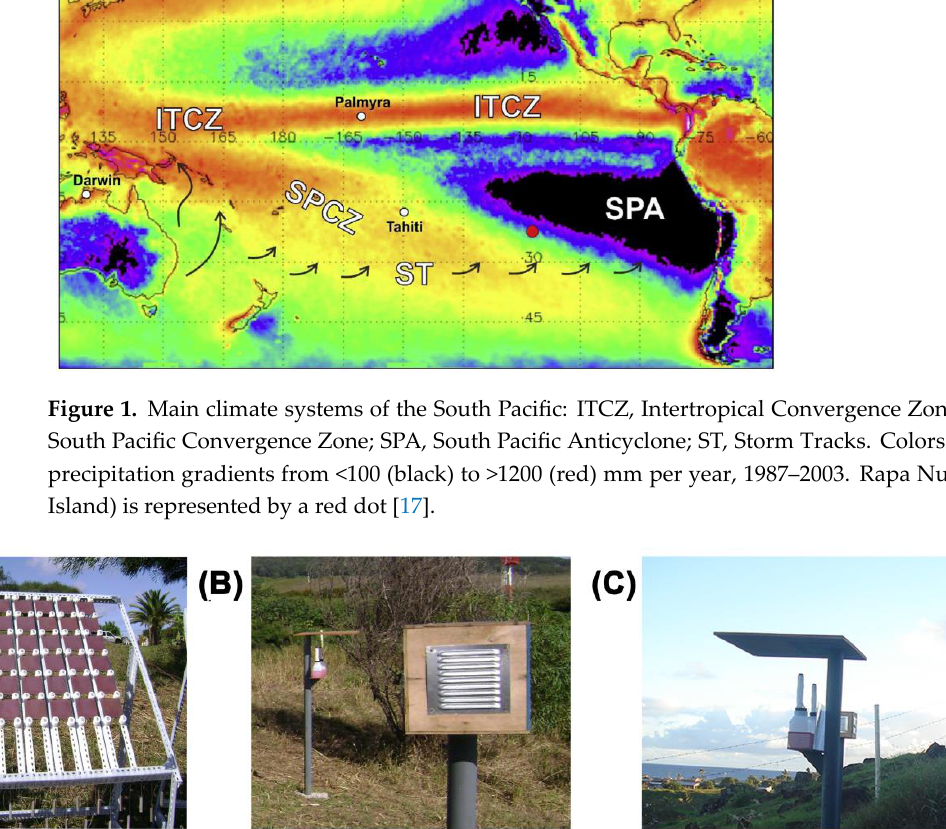
Figure 1. Main climate systems of the South Pacific: ITCZ, Intertropical Convergence Zone; SPCZ, South Pacific Convergence Zone; SPA, South Pacific Anticyclone; ST, Storm Tracks. Colors indicate precipitation gradients from <100 (black) to >1200 (red) mm per year, 1987 – 2003. Rapa Nui (Easter Island) is represented by a red dot [17].